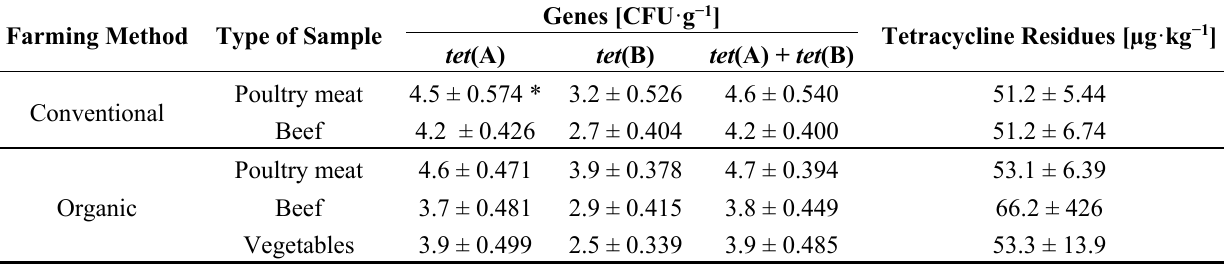
Table 2. Mean counts of bacteria harboring the tet (A) and/or the tet (B) genes in conventional and organic baby foods based on poultry meat, beef and vegetables.